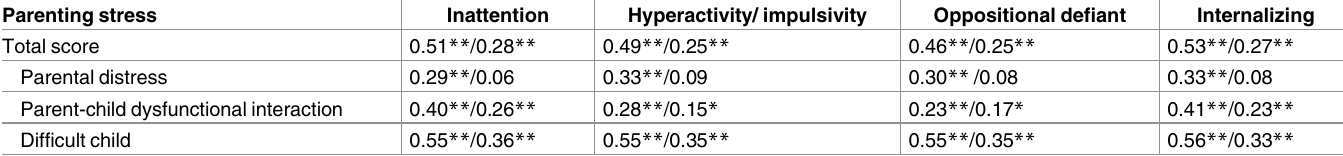
Table 3. Correlation matrix for parenting stress and symptom ratings.